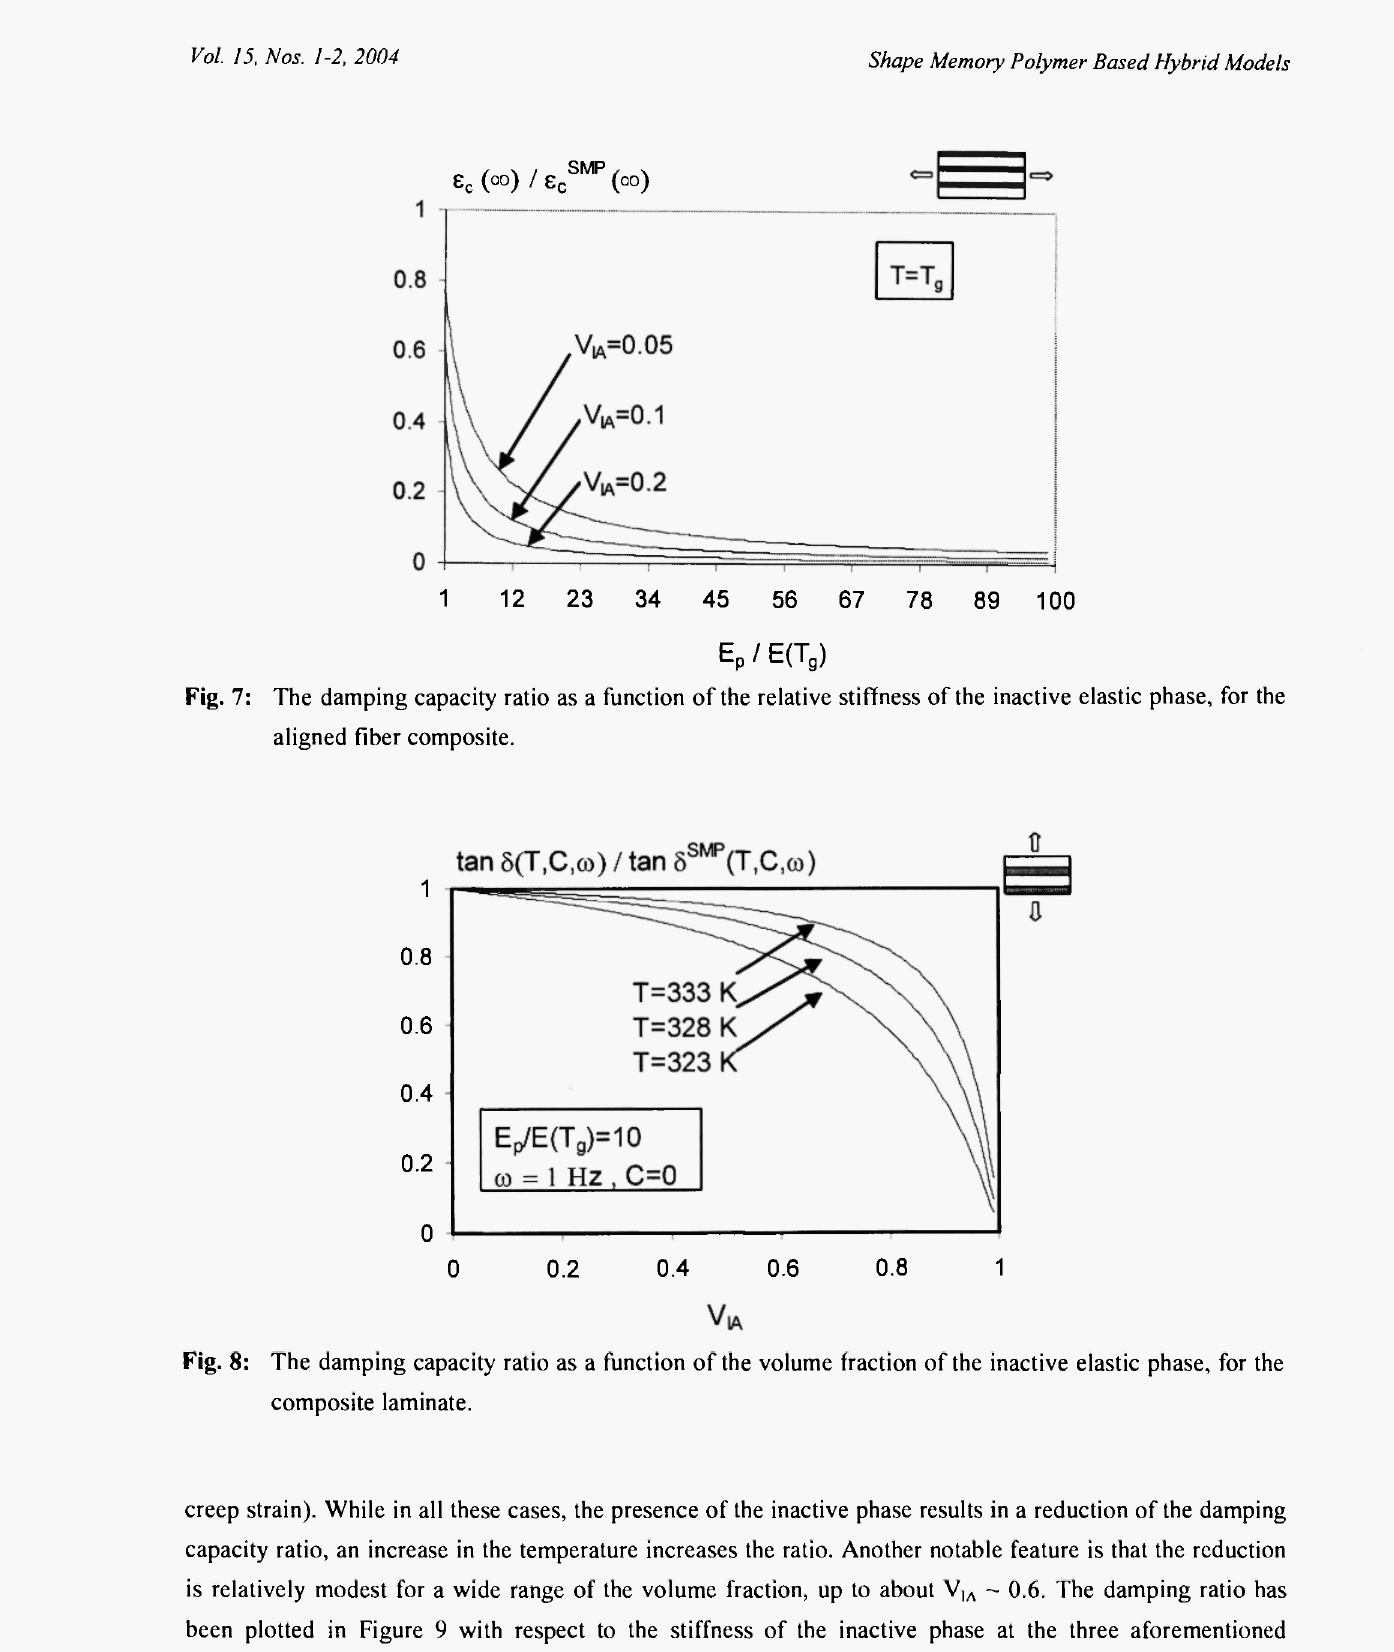
Fig. 8: The damping capacity ratio as a function of the volume fraction of the inactive elastic phase, for the composite